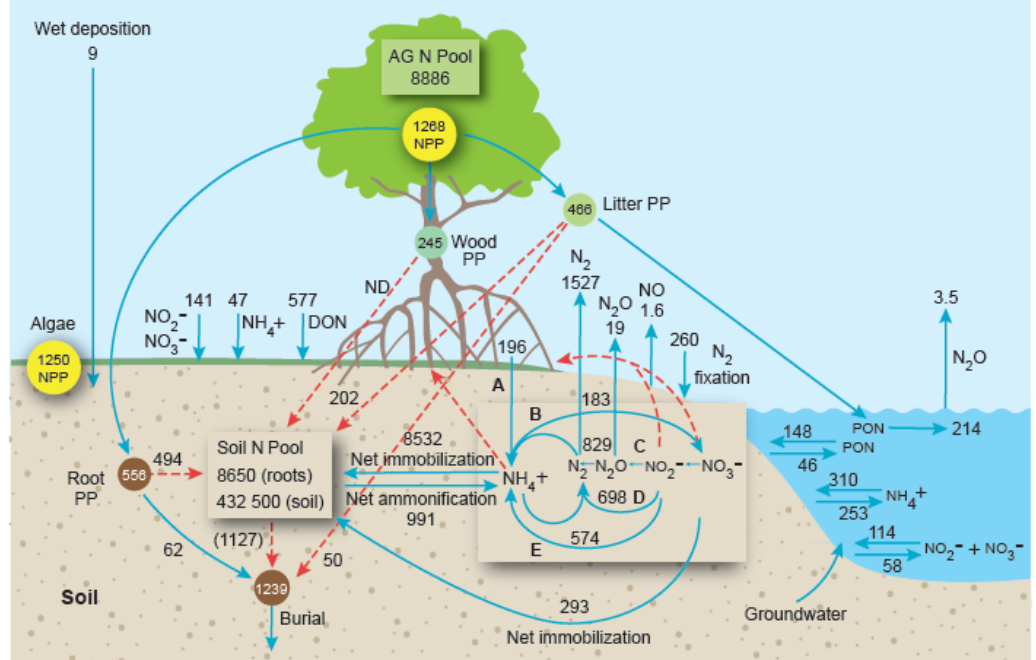
Figure 4. Nitrogen cycling in the world’s mangrove ecosystems. Mean fluxes = Gg N a − 1 ; mean standing stocks = Gg N. The model assumes a global mangrove area of 86,495 km 2 [242]. Soil N transformations are lettered as: ( A ) root + rhizome N 2 -fixation; ( B ) net nitrification; ( C ) denitrification; ( D ) anammox; ( E ) dissimilatory nitrate reduction to ammonium. Dashed red arrows represent mean values estimated indirectly (by di ff erence); solid blue arrows represent mean values based on empirical measurements (see text for explanation and references). The N pool (both roots and soil) in soils to a depth of 1 m is presented as a box on left in the forest floor. N transformation in soils to depths of 5–20 cm is presented as a box on the right in the forest floor. Unquantified inputs and outputs of dissolved nitrogen from land-derived groundwater and organic matter inputs from adjacent marine waters and catchments are not represented. Abbreviations: ND = no data; AG N Pool = aboveground forest N biomass pool; PP = primary production; NPP = net primary production; NO 2 − + NO 3 − = nitrite plus nitrate; NH 4 + = ammonium; N 2 = gaseous nitrogen; N 2 O = nitrous oxide; NO = nitric oxide; PON = particulate organic nitrogen.